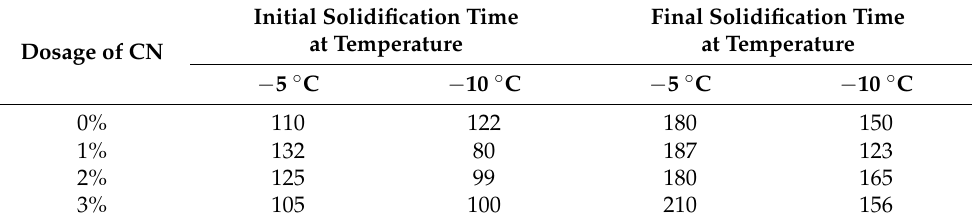
Table 6. Solidification time (min) at temperature − 5 ◦ C and − 10 ◦ C for CEM IIN